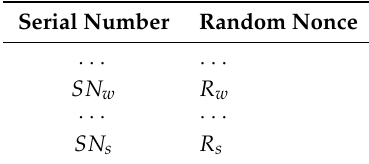
Table 1. Sequence numbers and random numbers of secret